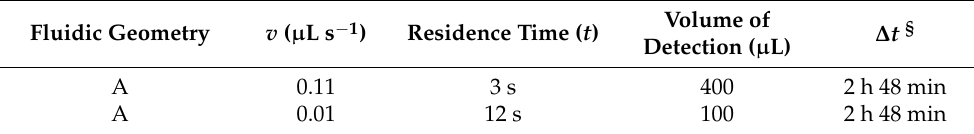
Table 2. Comparison of optimized parameters for flow rates and residency time under AC field with fluidic geometry A (see Appendix B, Figure A3b) for on-chip magnetic hyperthermia and fluorometric